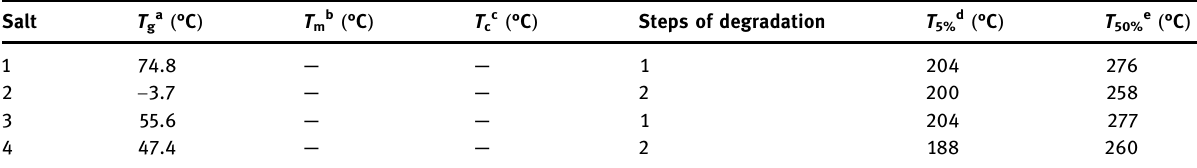
Table 2: Thermal properties of the obtained salts ( 1 – 4 )